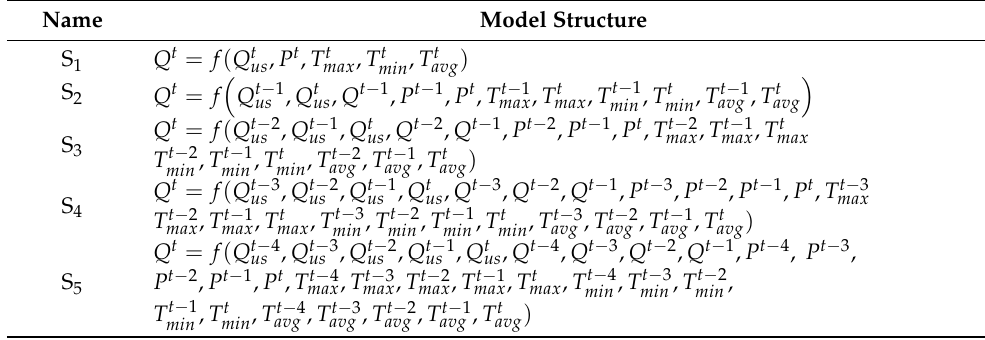
Table 1. The model structures used in the GRU